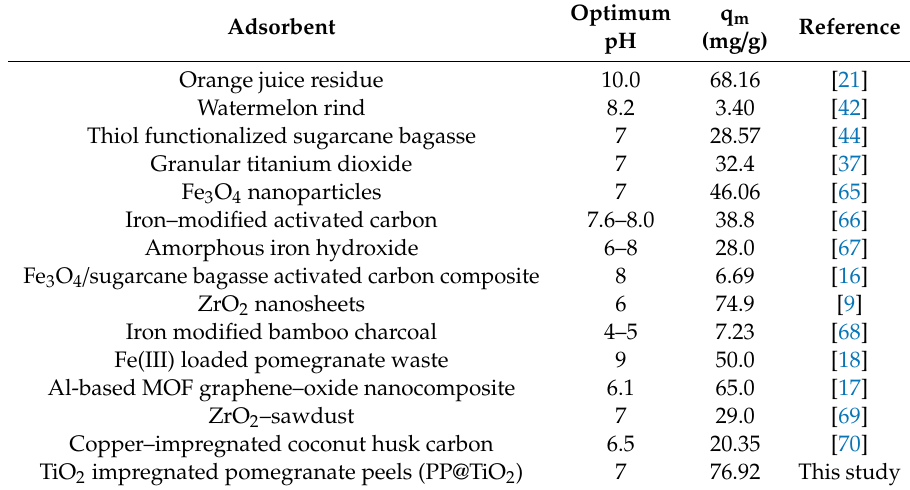
Table 2. Comparison of the maximum adsorption capacity (q m ) of di ff erent adsorbents for